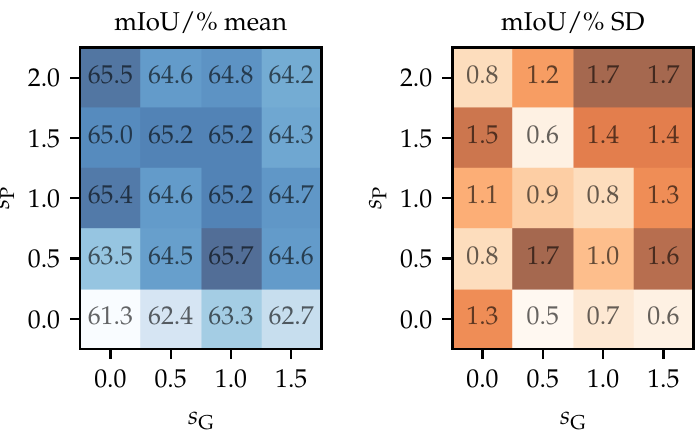
Figure 5. Validation of perturbation strength hyper-parameters on Cityscapes val (mIoU/%). We use 5 different subsets with 1/4 of the total number of training labels. The hyper-parameters s P (photo- metric) and s G (geometric) are defined in the main text. SD denotes the sample standard deviation.